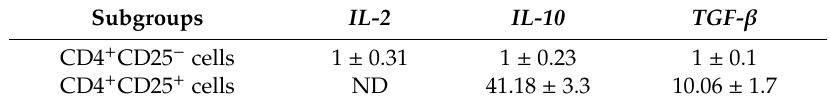
Table 2. The relative expression of IL-2 , IL-10 , TGF- β mRNA in CD4 + CD25 + cells.